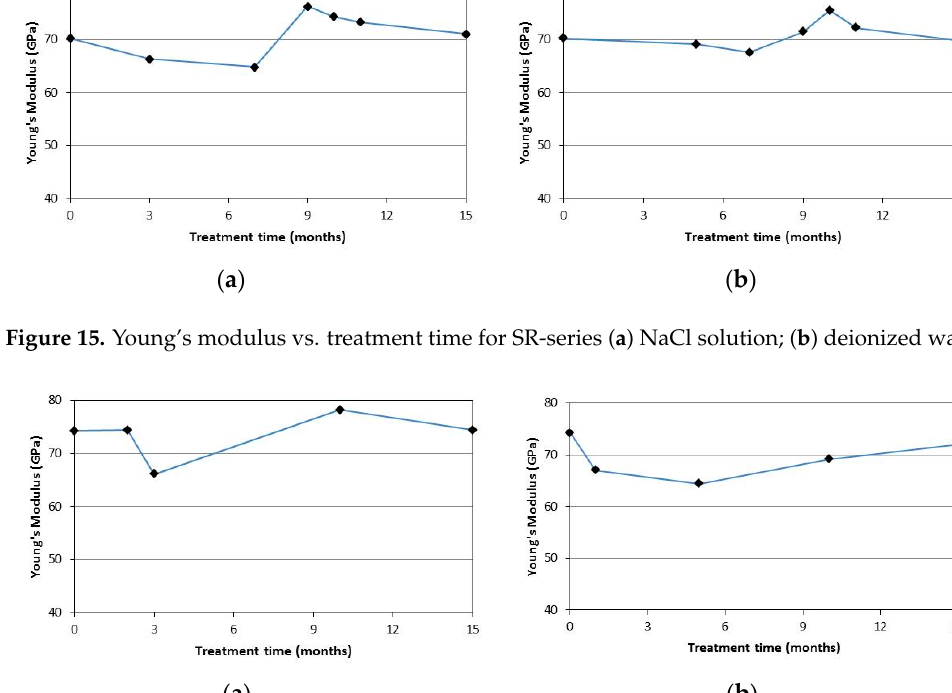
Figure 16. Young’s modulus vs. treatment time for SC-series: ( a ) NaCl solution; ( b ) deionized water.